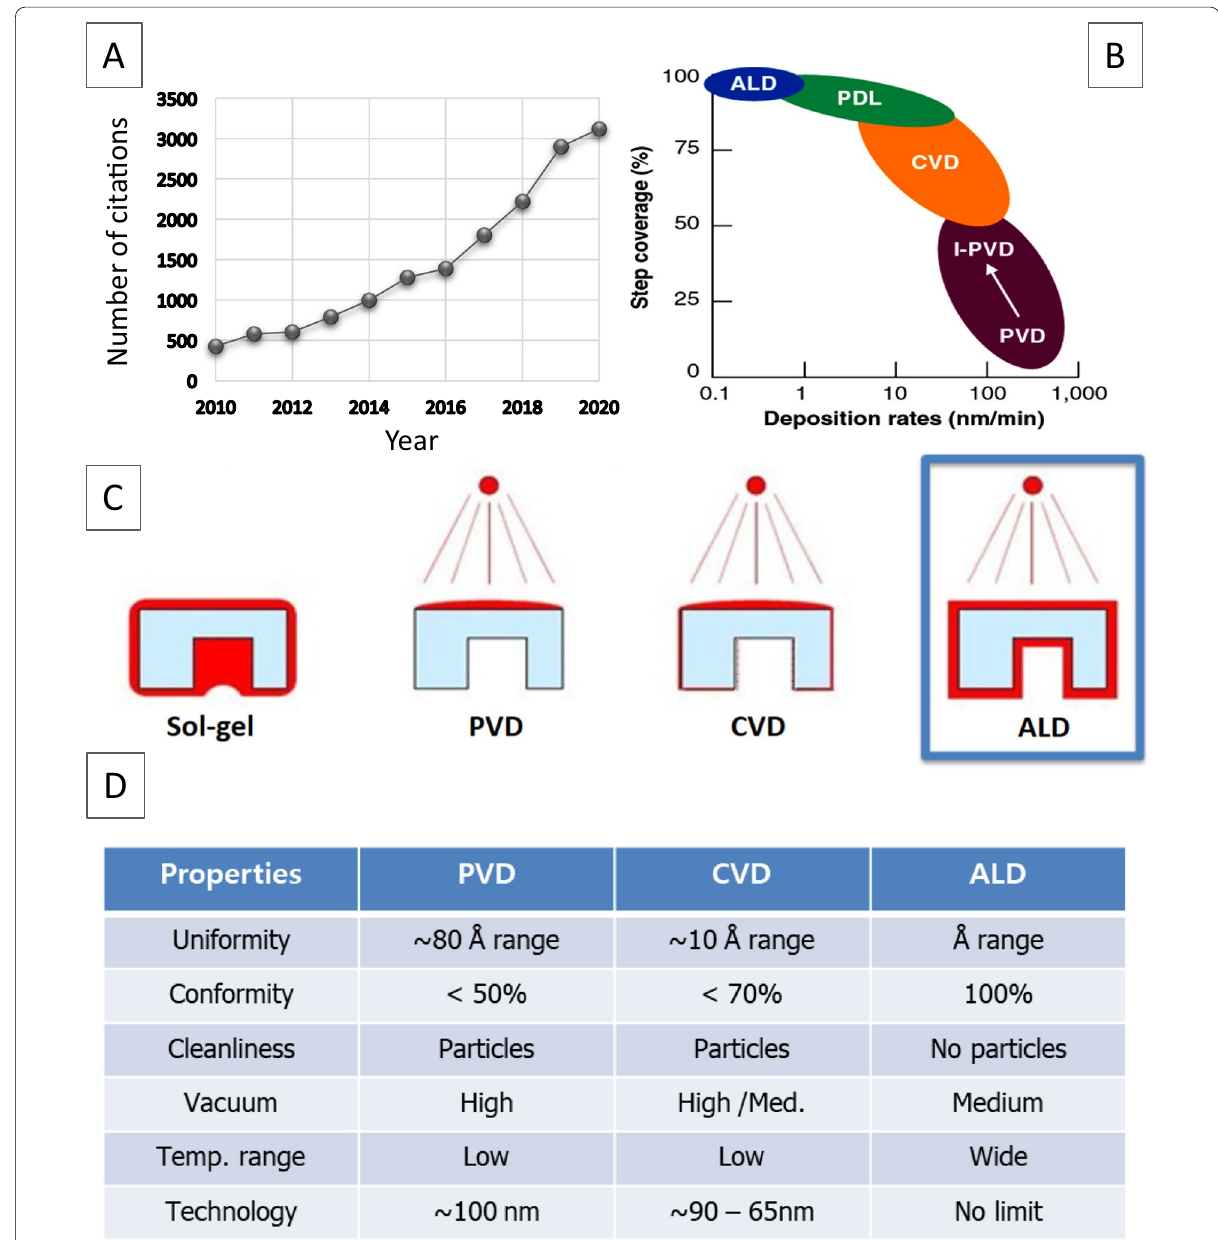
Fig. 6 Number of annual citations on “Atomic layer deposition” topic a of published manuscripts. Data are according to Web of Knowledge ™ Database. Comparison of the deposition rate vs step coverage ( b ) and coverage areas produced by different deposition techniques ( c ). Comparative analysis of properties of SE fabricated by PVD, CVD, and ALD, respectively ( d ). Reproduced with permission from